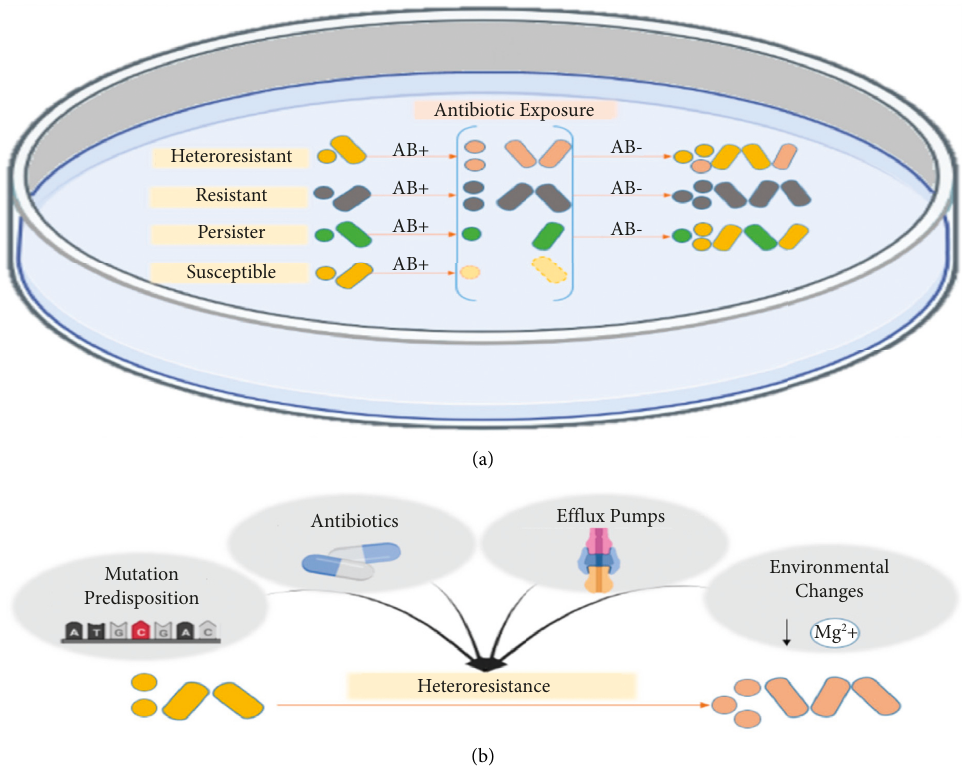
Figure 1: The difference between HR, resistance, persistence, and susceptibility and influential factors in the emergence of HR. (a) In the presence of antibiotic agents, heteroresistant cells can survive and grow in the presence of the antibiotic. Since the HR phenotype is unstable, cells return to the susceptible cell phenotype without antibiotic agents. On the other hand, resistant cells grow in the presence of antibiotics and remain resistant in their absence because genetic changes in resistance are stable, unlike HR. Persistence and HR are both sub- population-mediate resistance; however, although persister cells can survive antibiotic treatment, they do not grow or grow slowly in the presence of antibiotic agents. In the absence of the antibiotic treatment, persister cells also switch back to the susceptible cell phenotype. (b) Several factors have been identified and hypothesized to be influential in HR emergence: antibiotic exposure, mutation susceptibility in some strains, environmental changes such as decreasing specific ions, and changes in expression of the